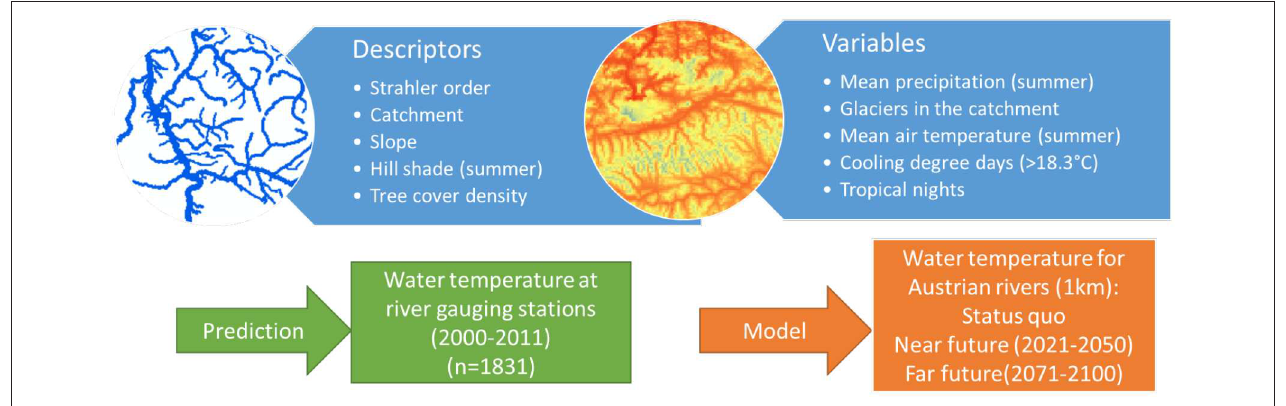
FIGURE 2 | Scheme of the Austrian wide water temperature model.